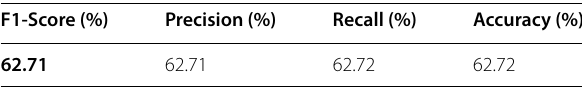
Table 6 Results of the ensemble system